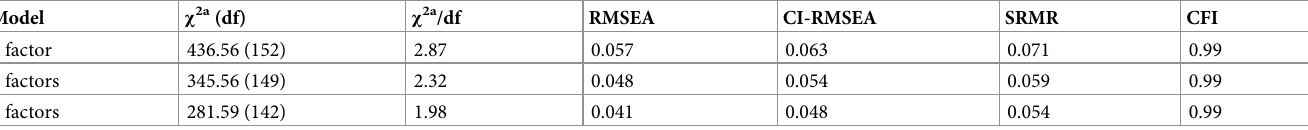
Table 3. Goodness-of-fit statistics of the one-factor model, the three-factor model and the five-factor model in the PD sample.